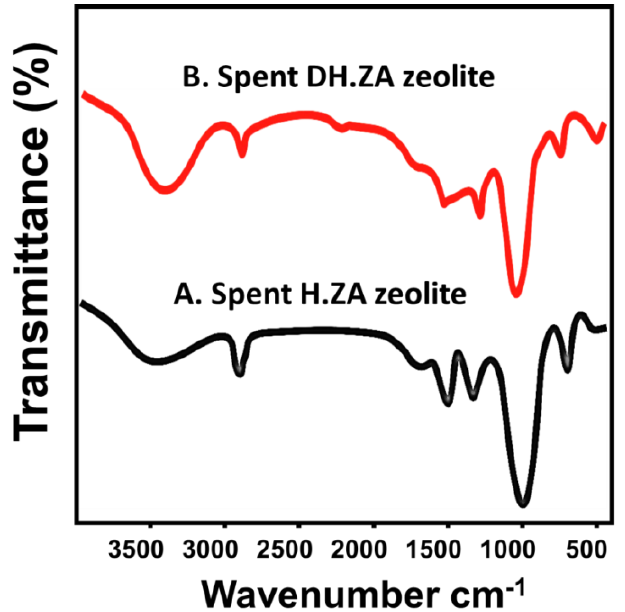
Figure 5. FT-IR spectra of spent H.ZA and DH.ZA after the transesterification reactions. Figure 5. FT - IR spectra of spent H.ZA and DH.ZA after the transesterification reactions.